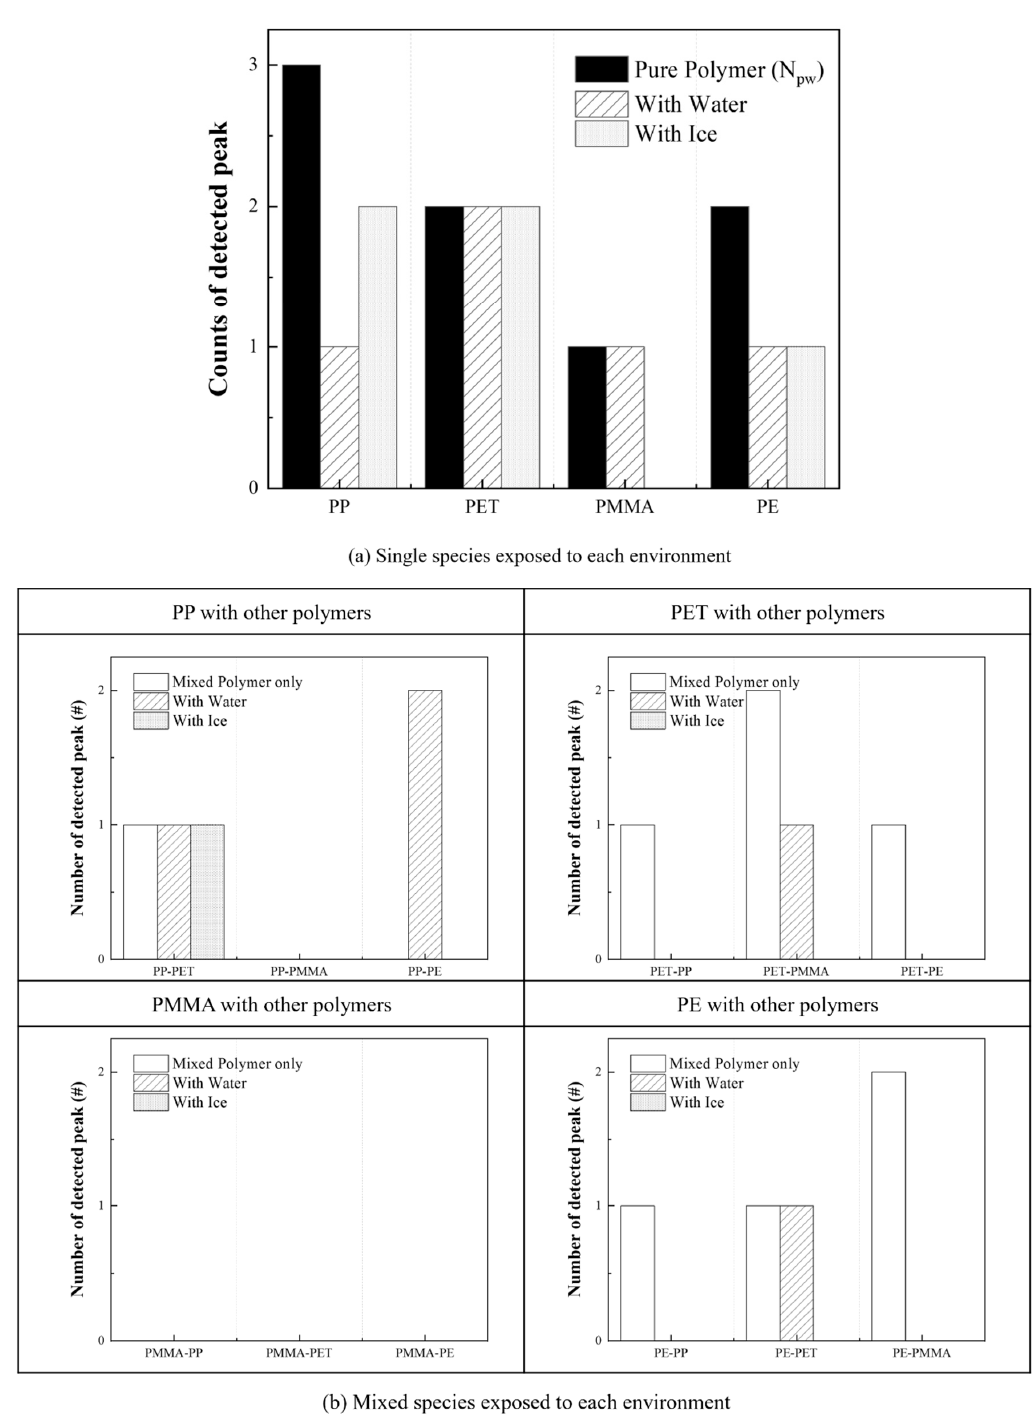
Figure 7. Degree of identification and classification of plastics under various conditions. ( a ) Single species and ( b ) polymer mixture.